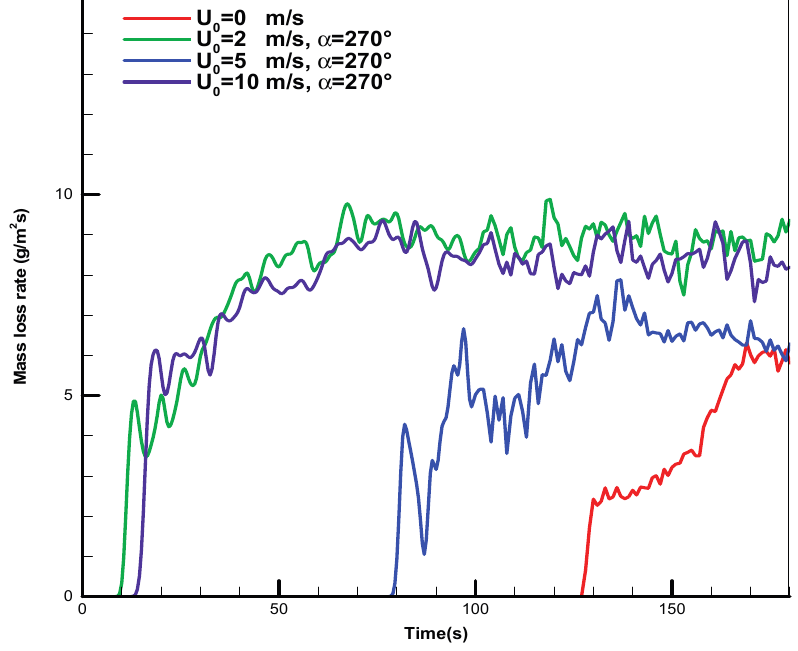
Figure 19. History of the mass loss rate of the composite material for the different wind